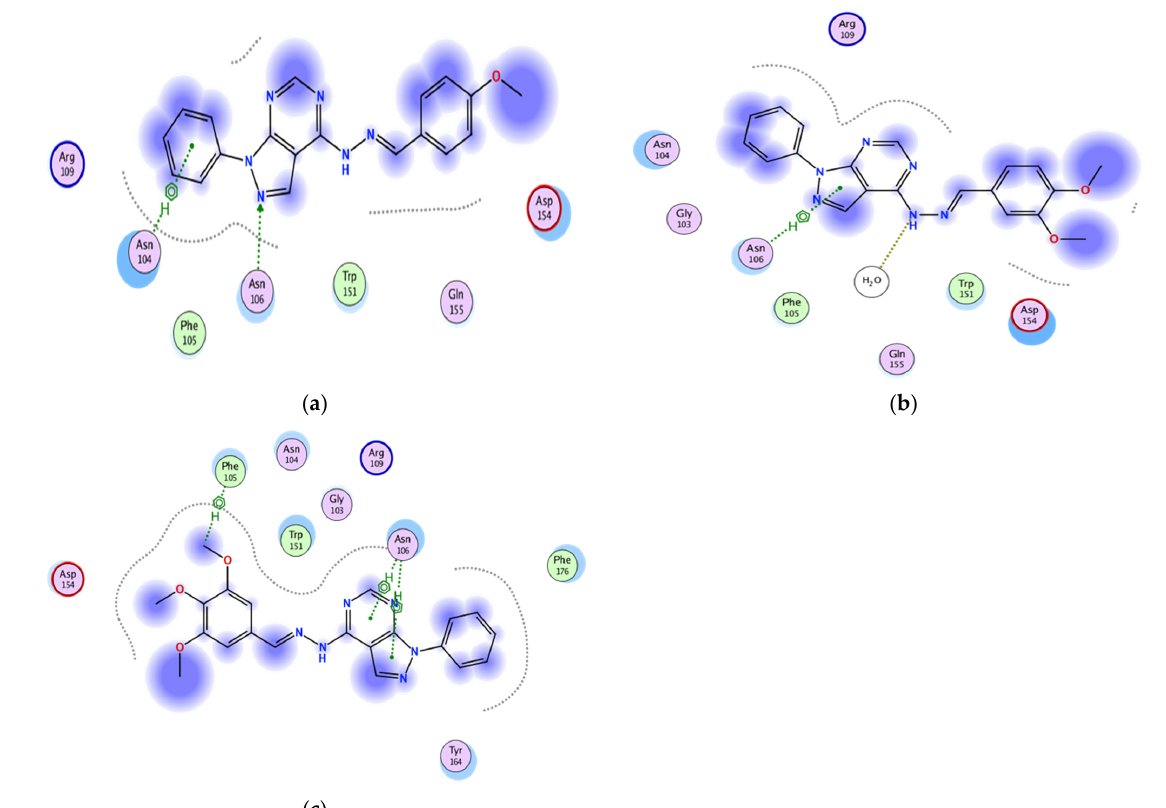
Figure 6. Two-dimensional binding mode of the test compounds ( a ) 6 , ( b ) 5 , and ( c ) 7 in the binding site of Bax protein (PDB ID: 6eb6) using MOE software.